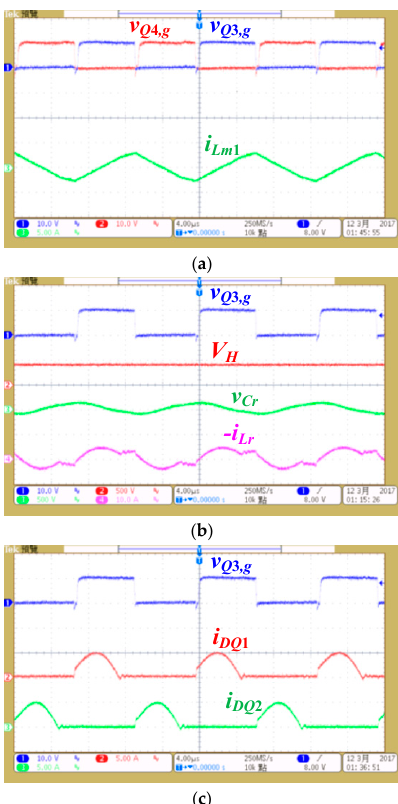
Figure 12. Test results under backward power transfer and full load with V L = 52 V ( a ) v Q 3 ,g , v Q 4 ,g and i Lm 1 [ v Q 3 ,g , v Q4,g : 10 V/div; i Lm 1 : 5 A/div; time: 4 µs/div] ( b ) v Q 3 ,g , V H , v Cr and − i Lr [ v Q 3 ,g : 10 V/div; V H , v Cr : 500 V/div; − i Lr : 10 A/div; time: 4 µs/div] ( c ) v Q 3 ,g , i DQ 1 and i DQ 2 [ v Q 3 ,g : 10 V/div; i DQ 1 , i DQ 2 : 5 A/div; time: 4 µs/div].